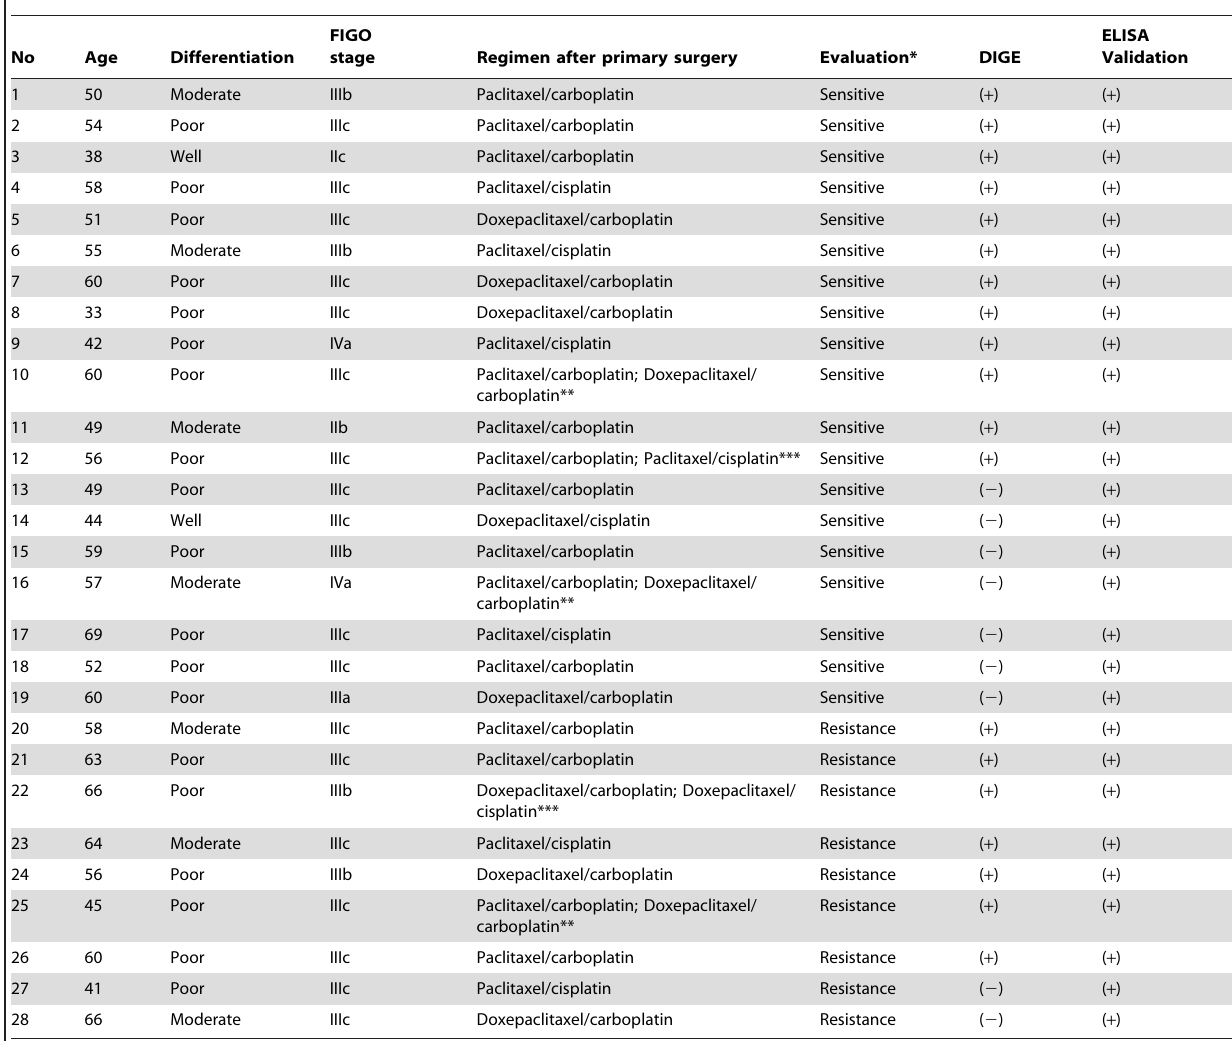
Table 1. Clinical characteristics of study subjects.